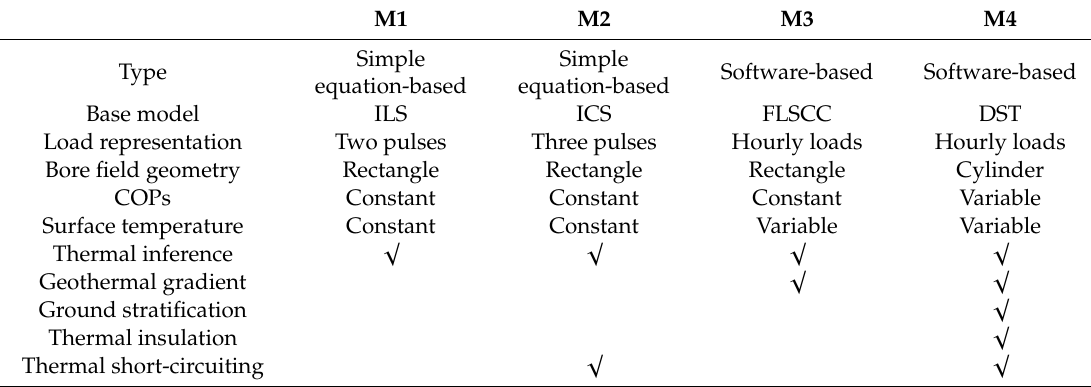
Table 2. Summary of the characteristics and inter-model considerations of sizing